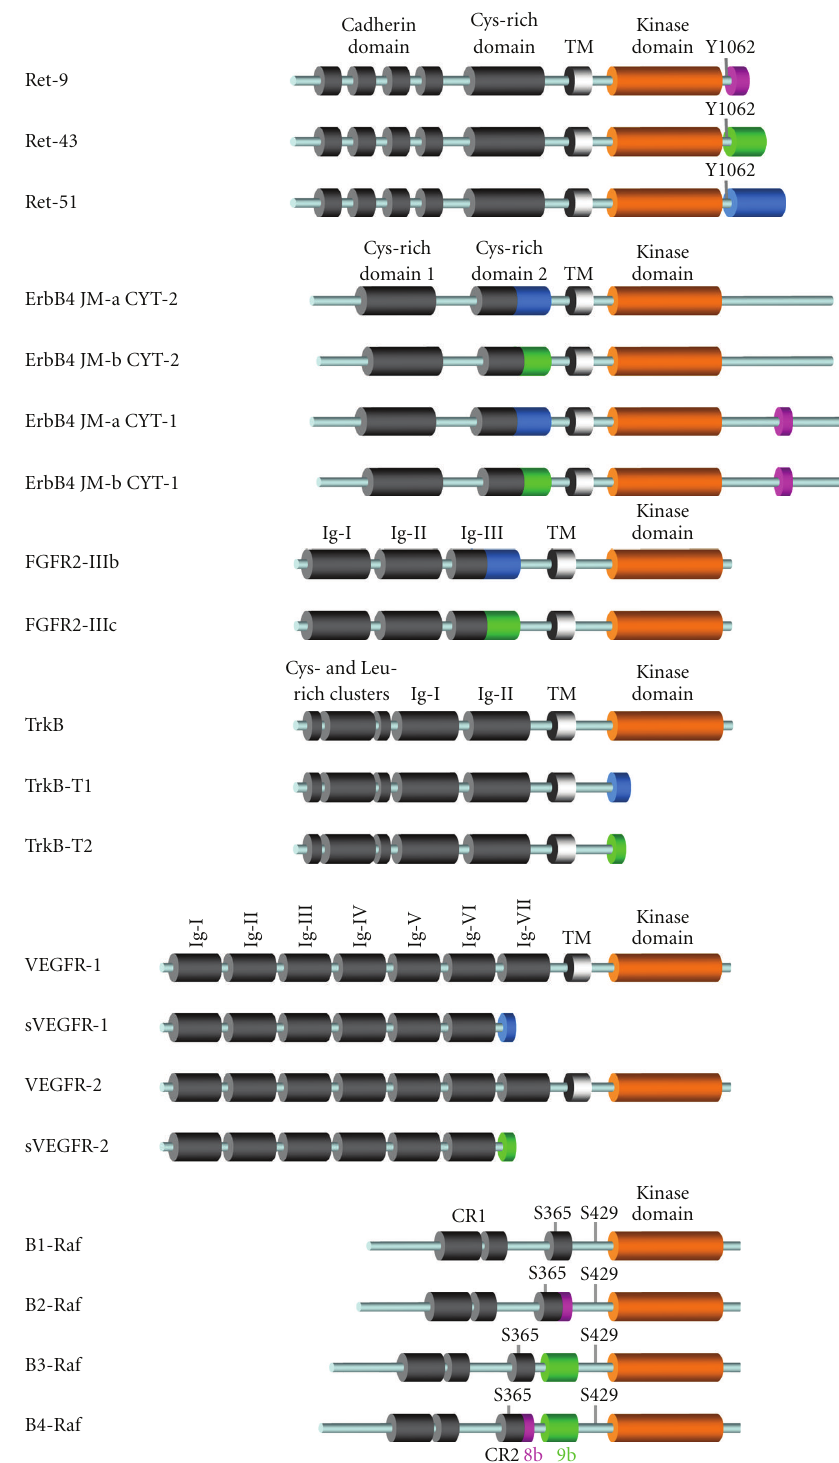
Figure 1: Splice variants of oncogenic kinases studied in mouse models. The various structural domains of oncogenic kinases are represented by cylinders. Amino acid sequences encoded by alternatively spliced exons are represented in pink, green, and blue. Abbreviations: transmembrane domain (TM), immunoglobulin-like domain (Ig), conserved region (CR), tyrosine (Y), and serine